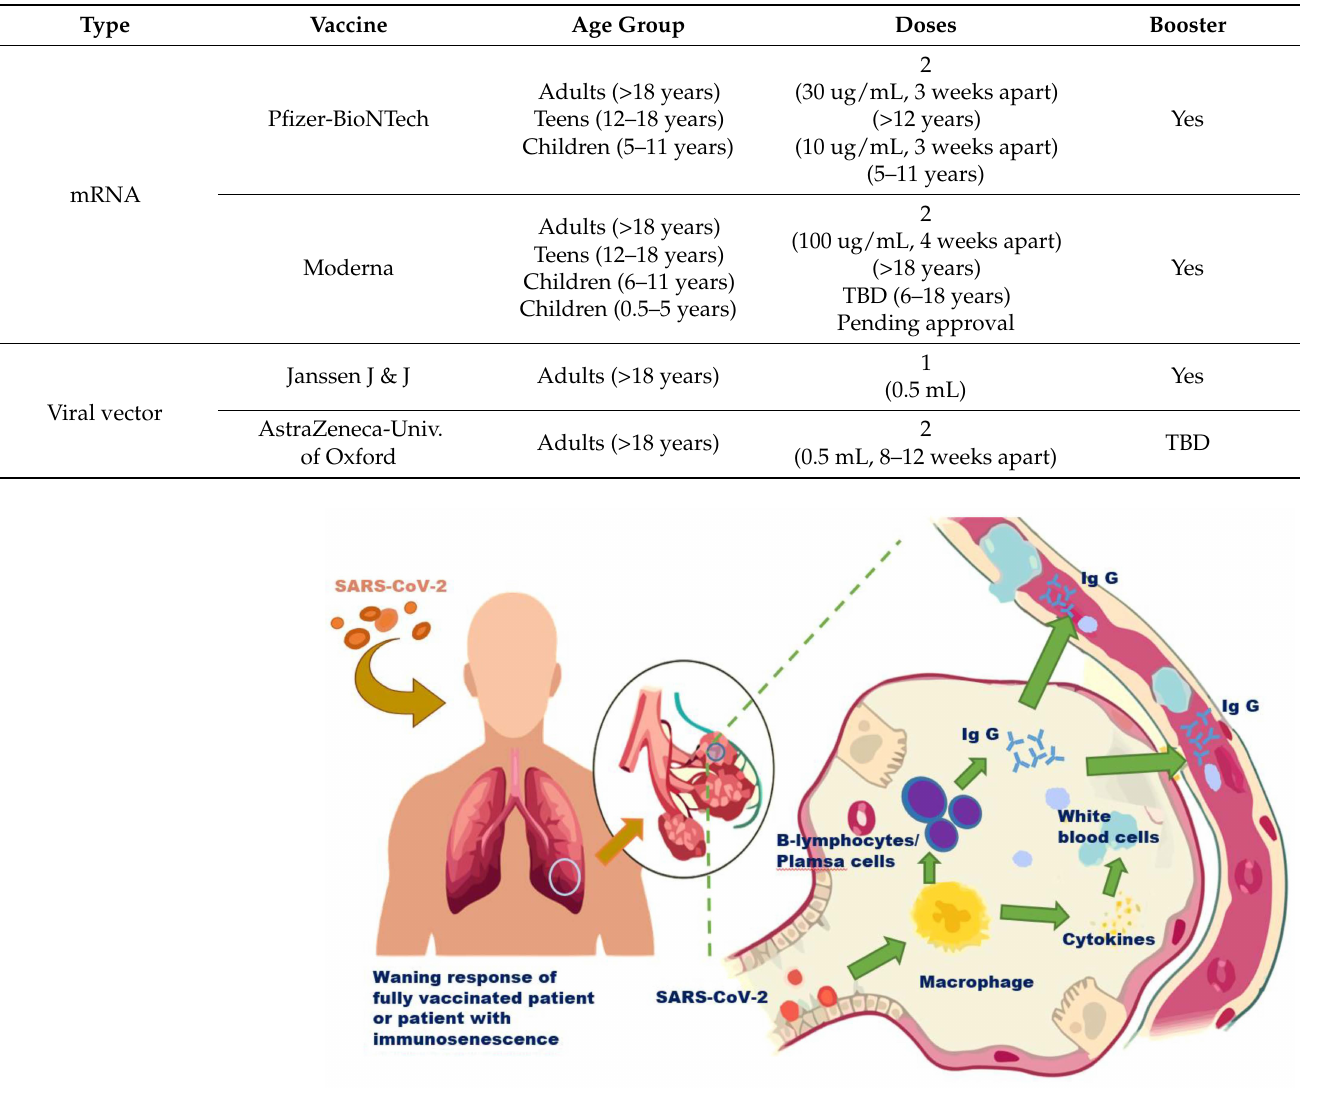
Figure 3. Immune response and IgG antibodies against SARS-CoV-2 reduced in waning fully vacci- nated patient or patient with